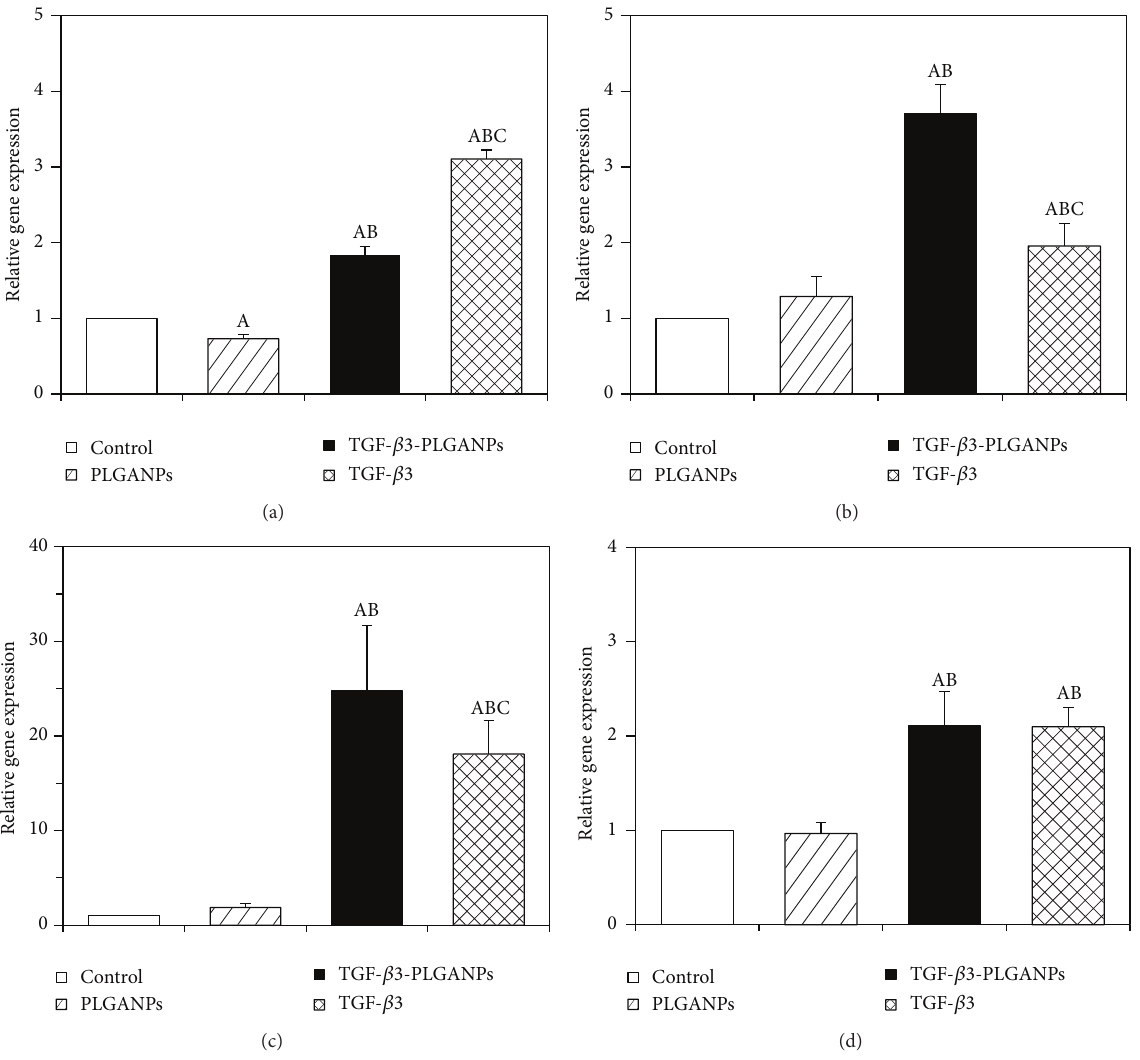
Figure 6: The expressions of (a) KRT18, (b) Shh, (c) aggrecan, and (d) type II collagen 𝛼 1 of MSCs in the dextran/gelatin hydrogel with no supplement (control), 1000 𝜇 g/mL blank PLGANPs (PLGANPs), 1000 𝜇 g/mL TGF- 𝛽 3-loaded PLGANPs (TGF- 𝛽 3-PLGANPs), and the hydrogels with no supplements cultured in the medium containing 10ng/mL TGF- 𝛽 3 (TGF- 𝛽 3) for 28 days. The expression levels were quantified using real-time PCR and normalized to the housekeeping gene, GAPDH. The data were expressed as the mean ± SD ( 𝑛 = 3 ). The samples indicated with (A) had a significant difference compared to the control group ( 𝑝 < 0.05 ), (B) had a significant difference compared to the TGF- 𝛽 3-PLGANPs group ( 𝑝 < 0.05 ), and (C) had a significant difference compared to TGF- 𝛽 3 group ( 𝑝 < 0.05